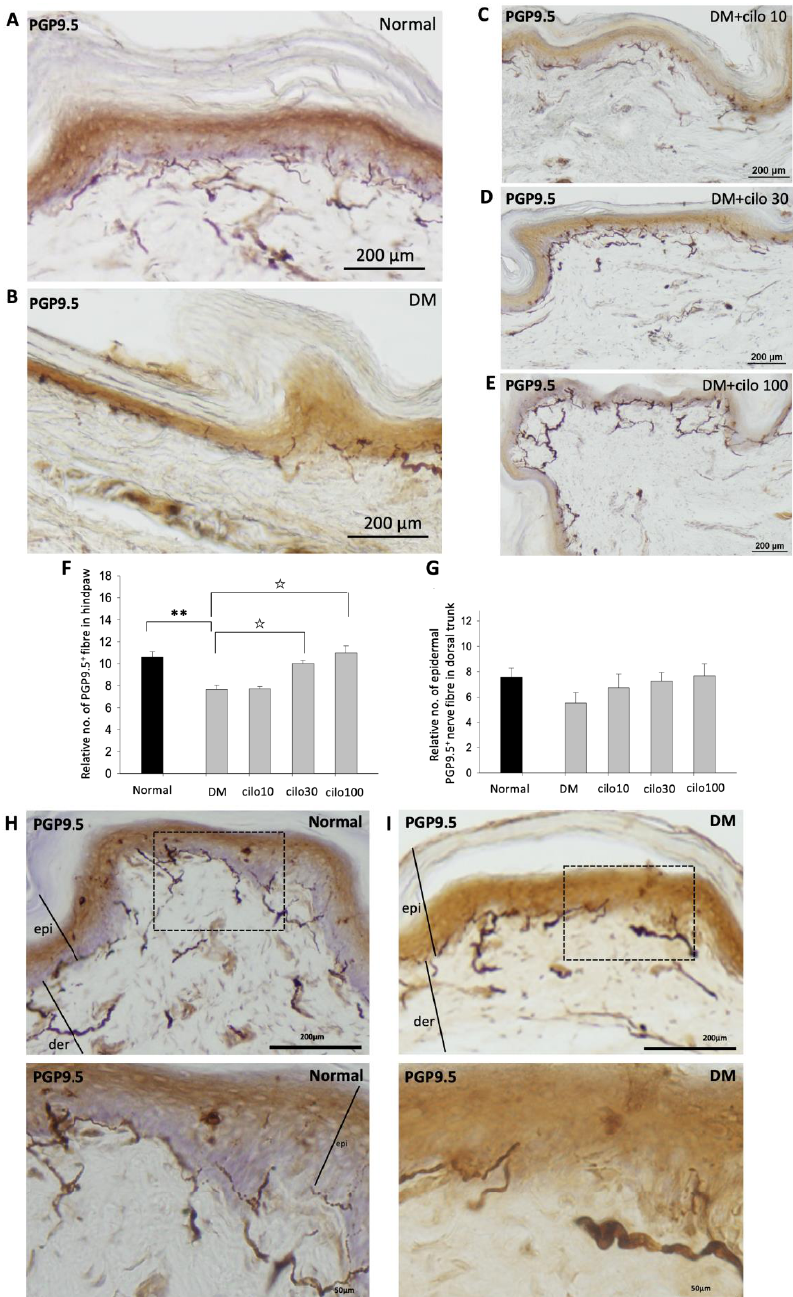
Figure 2. Ameliorated levels of PGP9.5-positive nerve endings in hind paws of cilostazol (cilo)- treated diabetic rats. PGP9.5 immuno-labeled sensory nerve fibers are indicated by white arrowheads in cryo-sectioned hind paw samples from ( A ) control rats, ( B ) DM rats, and DM rats receiving ( C ) 10 mg/kg (Cilo10), ( D ) 30 mg/kg (Cilo30), and ( E ) 100 mg/kg (Cilo100) daily dosage of cilostazol. Relative densities of intra-epidermal PGP9.5-positive nerve fiber ( F ) in the epidermal layer of hind paws or ( G ) in the epidermal layers of the back trunk skin are shown. Compared to the control group ( H ), reduction and swelling or shortening of PGP9.5-positive nerve fibers were observed in STZ-induced diabetic rats’ hind paws. ( I ) Intraepidermal PGP9.5-positive sensory nerve endings are indicated by white arrowheads, and black arrows indicate dermal nerve bundles in the foot pad. Epi, epidermis; der, dermis. Cilo10, 10 mg/kg cilostazol; Cilo30, 30 mg/kg cilostazol; Cilo100, 100 mg/kg cilostazol. Bars represent the average number of detectable labeled fibers in 5 mm skin sections. ** Indicates p < 0.01, and ☆ at p < 0.001, Mann – Whitney U test. Error bars represent SE.